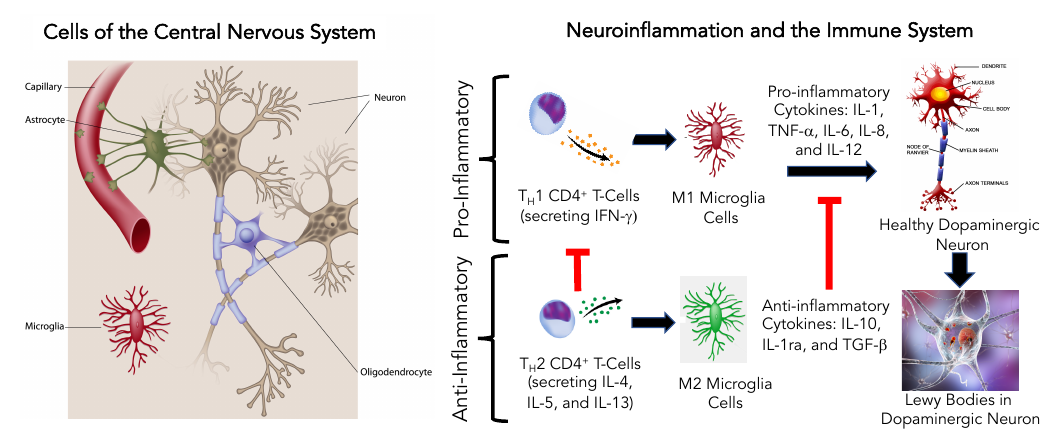
Figure 4. E ff ect of neuroinflammation and the immune system to promote Parkinson’s disease in the central nervous